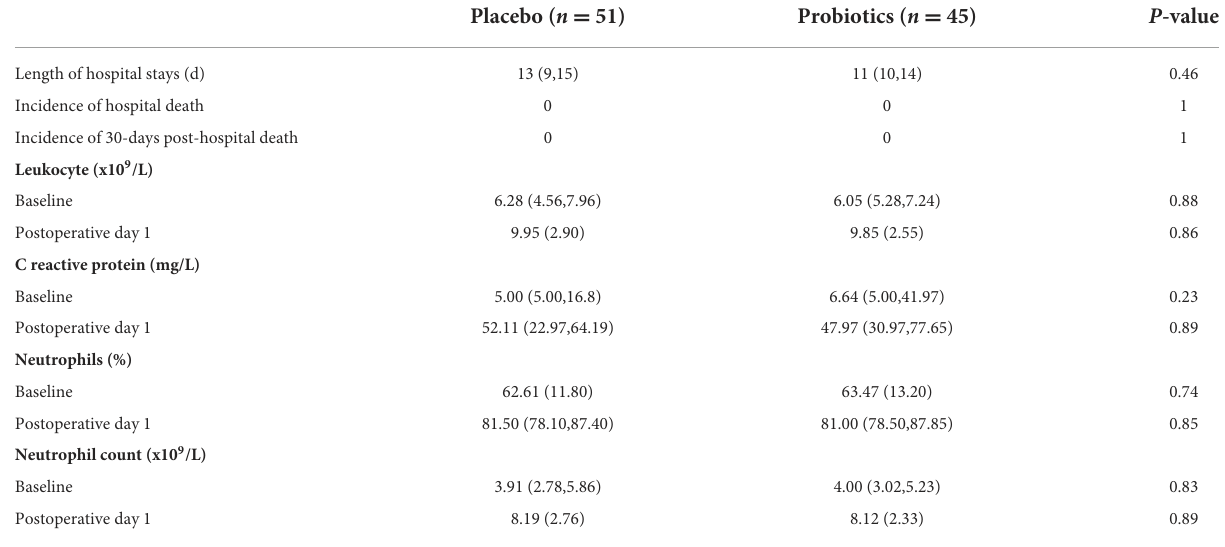
TABLE 6 Other clinical